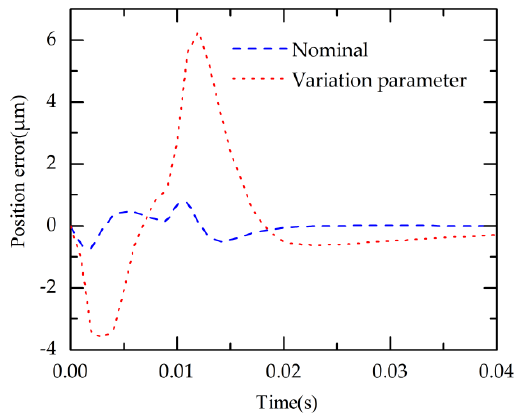
Figure 10. Simulation results of the proposed controller with random parameter variation. Appl. Sci. 2017 , 7 , 1283